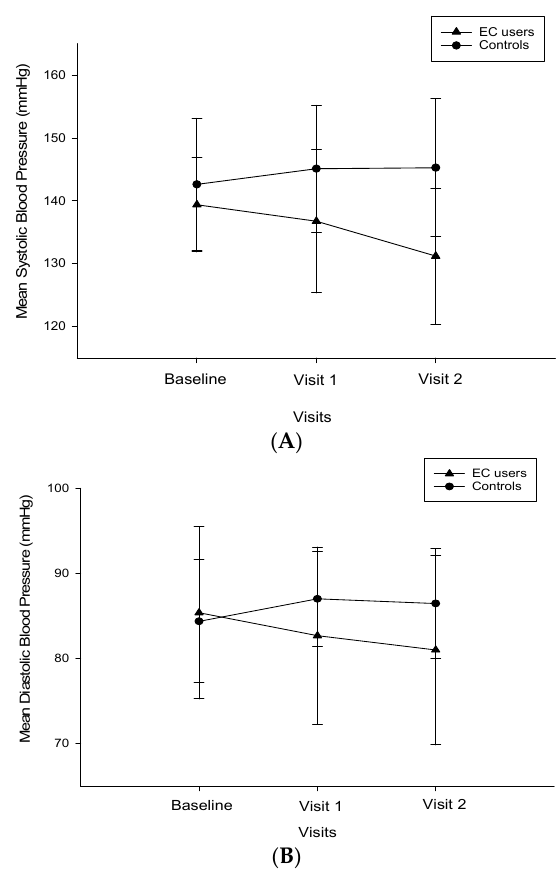
Figure 1. ( A ) Changes in systolic blood pressure from baseline, at visit 1 (6 ± 1 months) and visit 2 (12 ± 2 months) separately for electronic cigarettes users (closed triangles) and controls (closed circles). All data expressed as mean and error bars are standard error of the mean; ( B ) Changes in diastolic blood pressure from baseline, at visit 1 (6 ± 1 months) and visit 2 (12 ± 2 months) separately for electronic cigarettes users (closed triangles) and controls (closed circles). All data expressed as mean and error bars are standard error of the mean. Abbreviations: mmHg, millimeters of mercury.